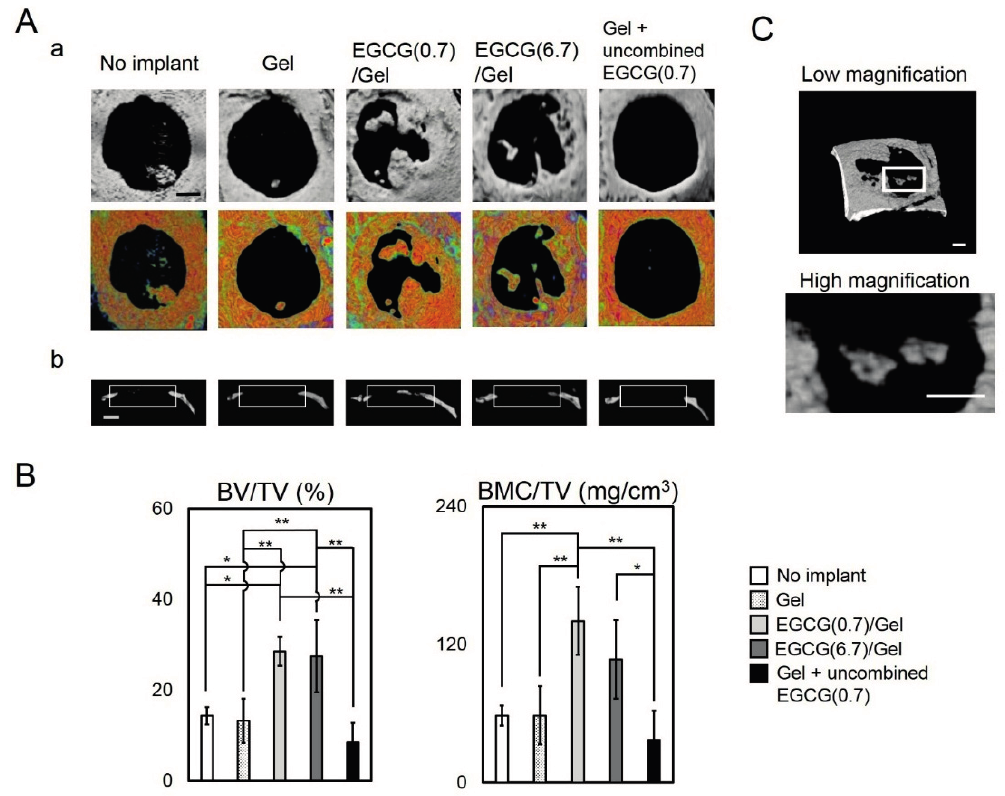
Figure 4. Micro computed tomography ( μ CT) and bone mineral density (BMD) images of Gel and EGCG/Gels and those quantitative data four weeks after implantation in the critical size defects of mouse calvaria. ( Aa ) Axial view of the μ CT and BMD images of treated calvaria; ( Ab ) Lateral view of μ CT images of treated calvaria. The width of the rectangles indicates the prepared bone defects; ( B ) Bone volume (BV) per total volume (TV) and bone mineral content (BMC) per TV in the defect. * p < 0.05; ** p < 0.01 (analysis of variance (ANOVA) with a Tukey-Kramer test). Data represent the mean with standard deviation ( n = 3 per group); ( C ) High and low magnification of radiopaque parts isolated from the edge of the defect. Bars: ( A , C ) 1